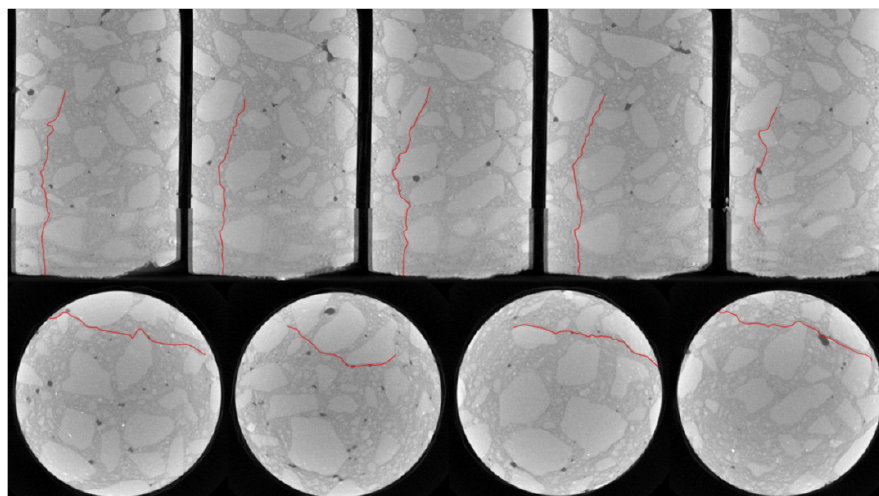
Figure 4. Type-I microcrack.